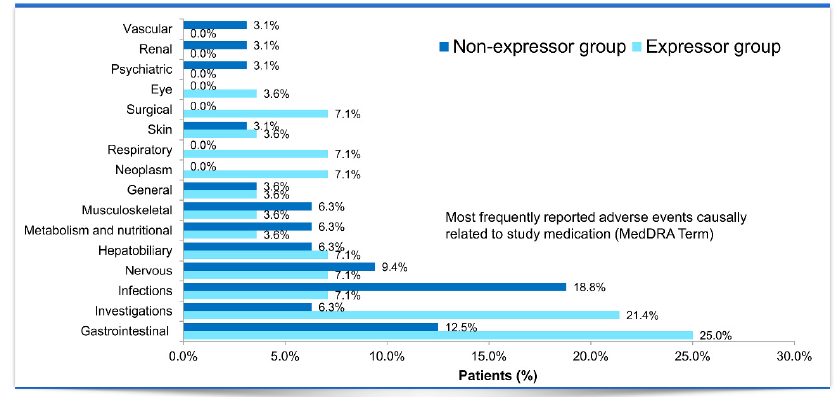
Figure 5. Adverse event profiles in the expressors and non-expressors (Full Analysis Set) after conversion from twice-daily to once-daily extended-release tacrolimus. Table 4. Adverse events stratified according to CYP3A5 expression.